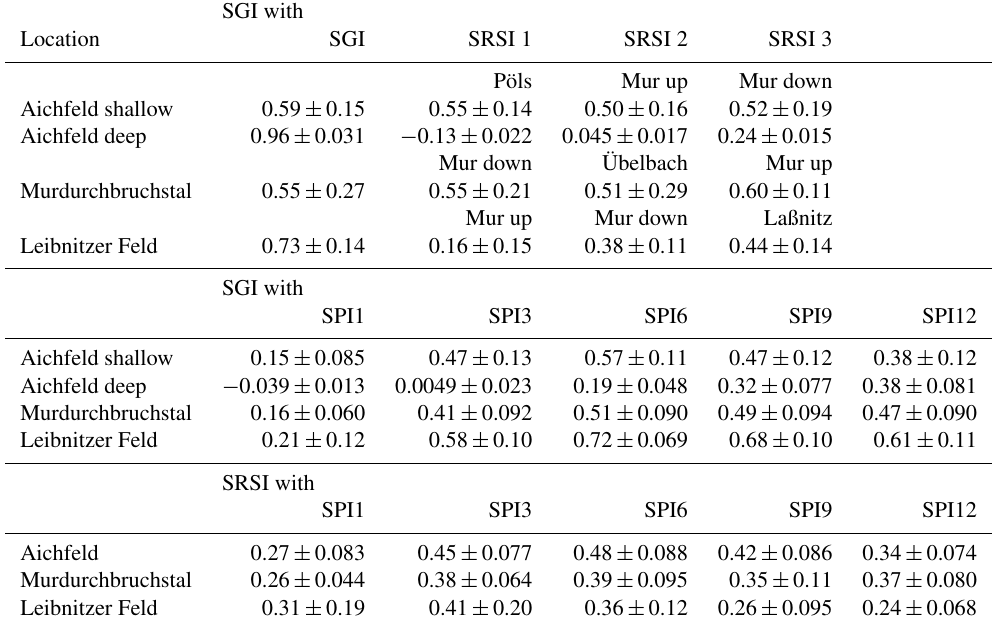
Table 2. Average Pearson correlation coefficients of a subregion for SGI time series with each other (SGI with SGI), SGI time series with single SRSI time series (SGI with SRSI 1, ...) and SPI averaging periods (SGI with SPI1, ...), and the average correlation coefficient for all SRSI time series of a subregion with the SPI averaging periods (SRSI with SPI1, ...) with their standard deviations for each